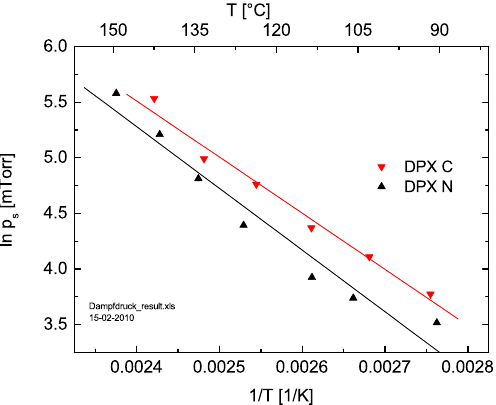
Figure 12. The vapor pressure strictly follows a Clausius-Clapeyron behavior